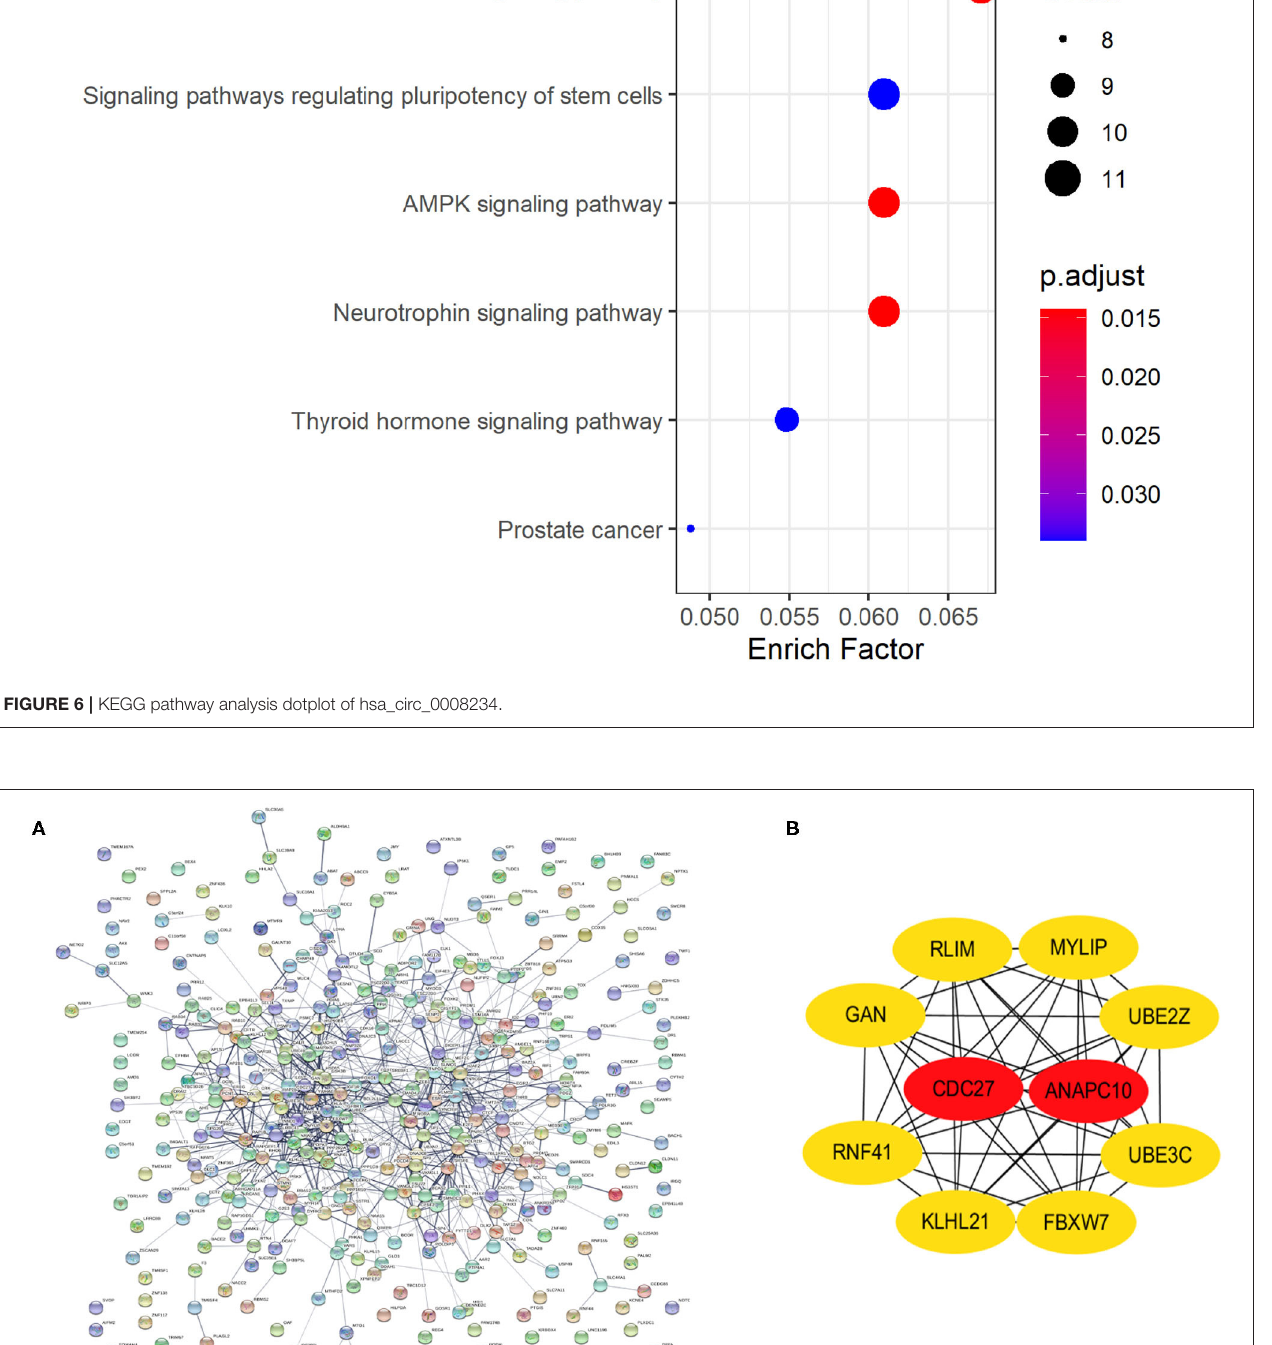
Frontiers in Genetics |